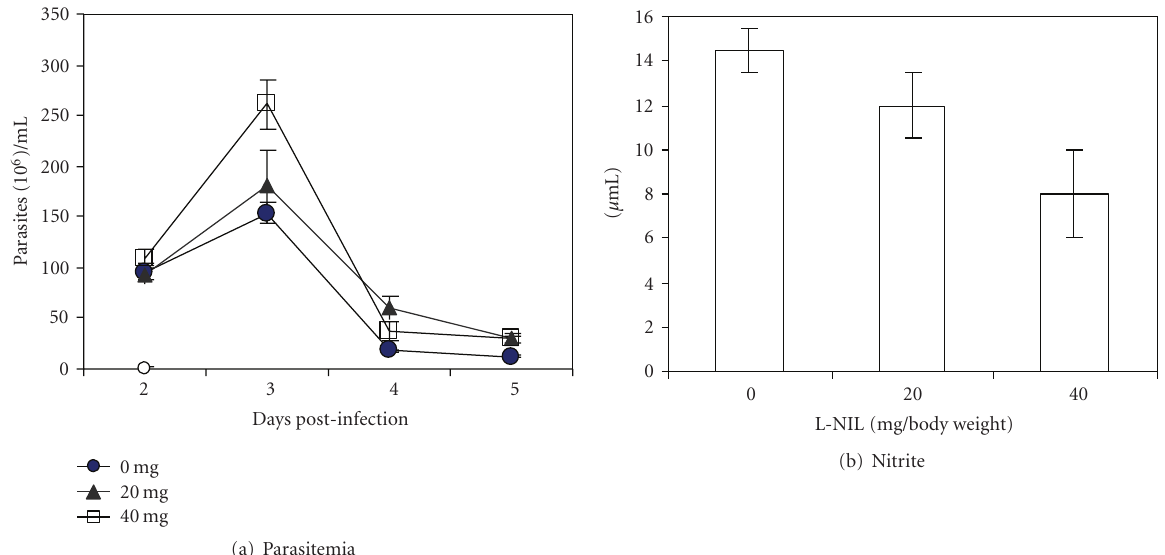
Figure 4: Treatment of mice with L-NIL, an iNOS-specific inhibitor, had no e ff ect on parasitemia but a moderate e ff ect on the production of NO in spleen cell cultures. Groups of 6 C57BL/6 mice were treated i.v. with L-NIL (20 or 40mg/ body weight) on day − 1, 1, 2, and 3 postinfection. Mice were infected i.p. with 5 × 10 6 T. congolense TC13 on day 0. Parasitemia (a) was determined. On day 6 postinfection, spleen cells were cultured at an optimal cell density (5 × 10 6 /mL) for 48 hours. Nitrite (b) in culture supernatants was measured by the Griess reaction. ∗∗ P ≤ . 01; ∗∗∗ P ≤ .